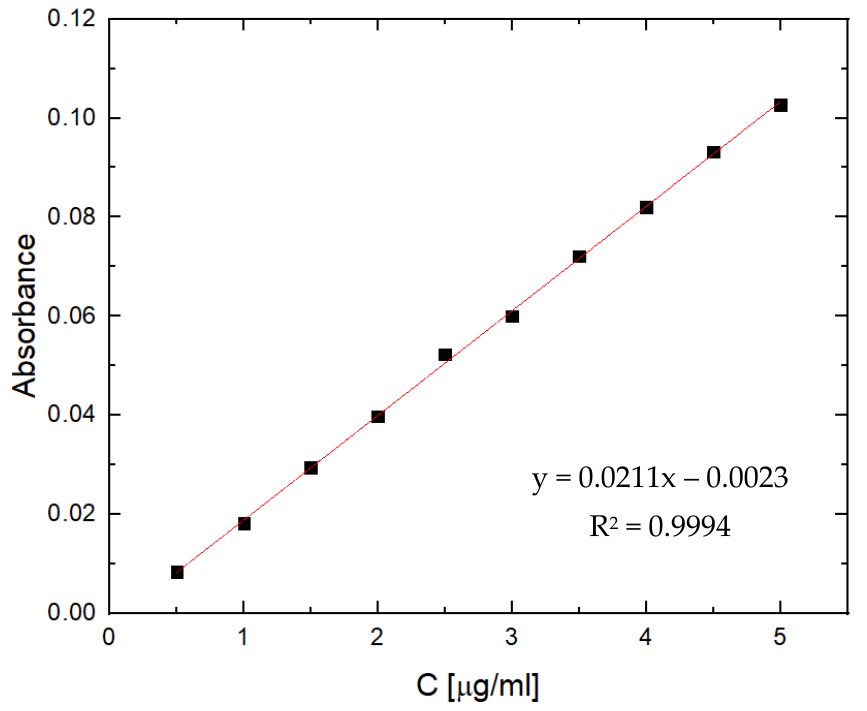
Figure 7. Calibration curve for timolol maleate at 294 nm.